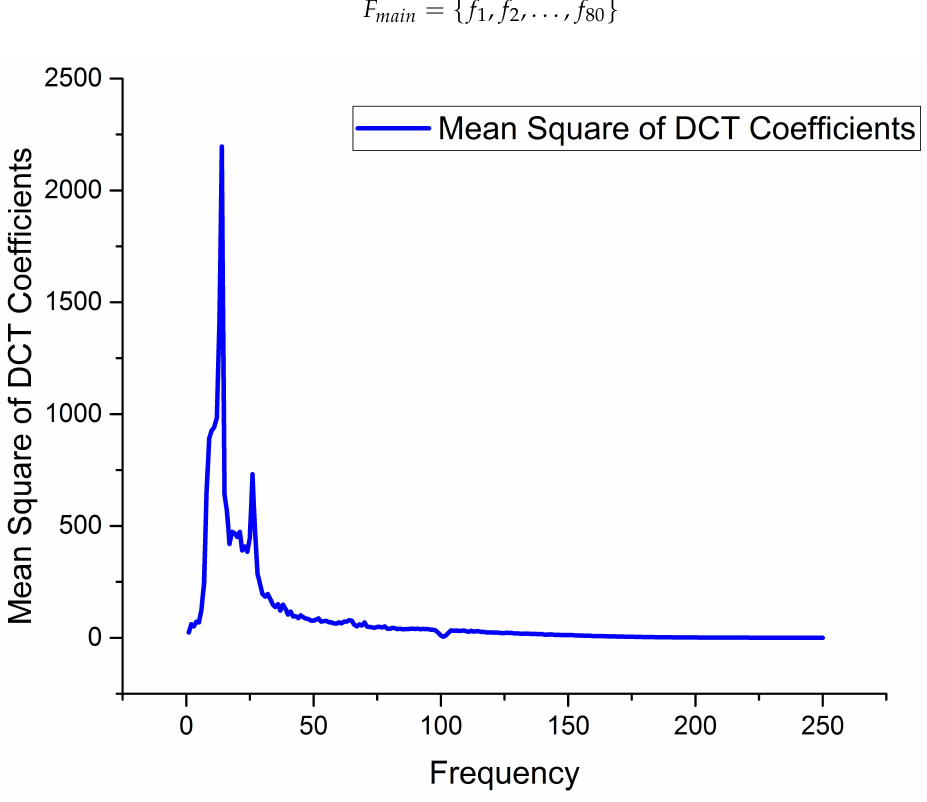
Figure 3. The mean of the squared values of the DCT